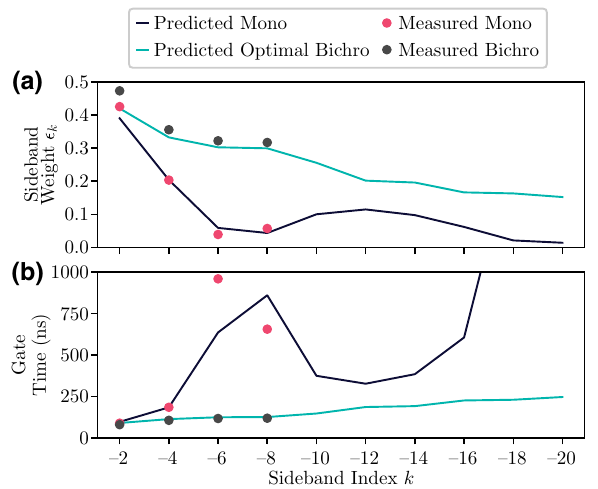
FIG. 5. (a) Predicted and measured sideband weights achiev- able with monochromatic and bichromatic modulation of qubit 5 (ref. Table I). All weights correspond to sweet spot flux oper- ating points for activating a CZ 02 interaction with qubit 6. See Appendix B for a description of the expressions used in simulat- ing a sideband weight for a given flux modulation. The predicted monochromatic data set is calculated in this way, using the modulation parameters corresponding to the single sweet spot interaction for each sideband. To select the optimal predicted bichromatic weight for a given sideband, modulation amplitude (cid:2) (cid:2) α is swept (cid:2) ac is swept from 0.1 0 to 0.9 0 and mixing angle from 0 to π/ 2. For each pair of (cid:2) ac and α , a relative phase θ is calculated that would create a sweet spot at (cid:2) ac if possible. For each of these operating points, we then calculate average detun- ing, required modulation frequency, and finally sideband weight and gate time according to the expressions in Appendix B. The operating point with the fastest predicted gate time is selected for each sideband, and the measured weights are extracted from the measured gate times at these operating points. (b) The predicted and measured gate times associated with the sidebands described in panel (a). In general, bichromatic operating points can be opti- mized to concentrate weight into the gate-activating sideband, dramatically reducing obtainable gate times at higher sideband